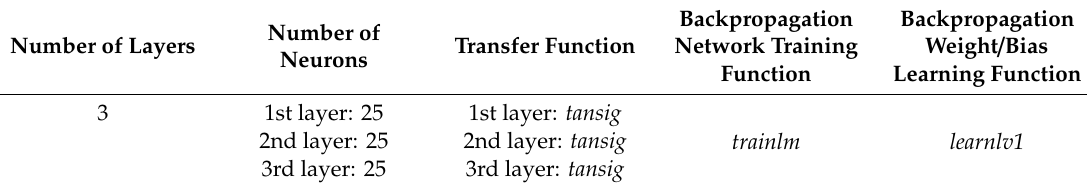
Table 2. Optimal values of the multilayer perceptron ANN parameters found by the Artificial Bee Colony (ABC) algorithm for the estimation of the Brix minus acid (BrimA)